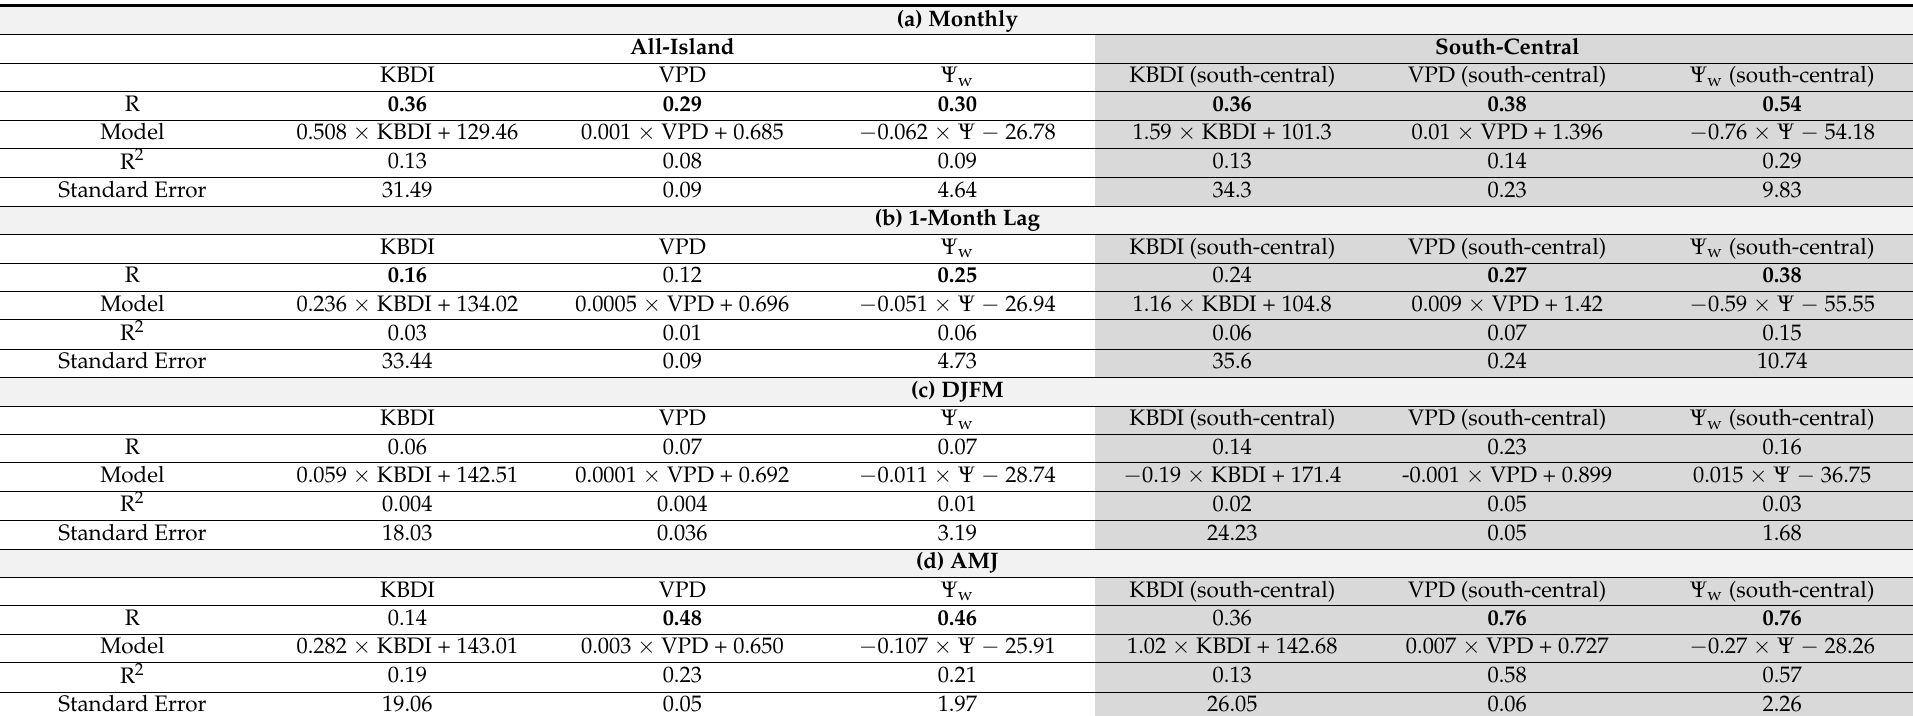
Table 5. Linear regression models for (a) monthly (b) monthly with 1-month lag (c–f) seasonal fire variability from MODIS based on KBDI, VPD and Ψ w . Columns 2–4 show all-island models using ERA5-derived bushfire potential indices. Columns 5–7 show models for south-central Jamaica. For south-central Jamaica, the monthly models are derived using station data-derived bushfire potential indices for 2013–2017 while the seasonal models are based on ERA5-derived bushfire potential indices for 2010–2019. The correlation coefficient (R), coefficient of determination (R 2 ); and standard error are also shown. Correlations in bold are statistically significant at the 95% confidence